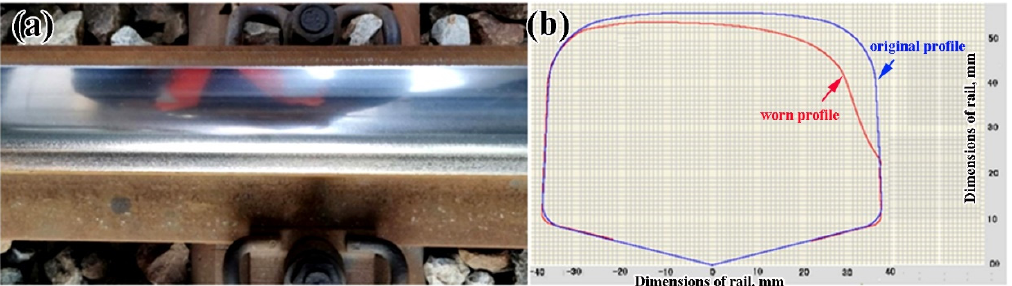
Figure 12. ( a ) Photograph of a 1380G bainitic rail steel after the experience of ~500 million gross tons at the curved track of heavy haul railway; ( b ) the cross-section profile, where the blue and red lines show the original and worn profiles, respectively.